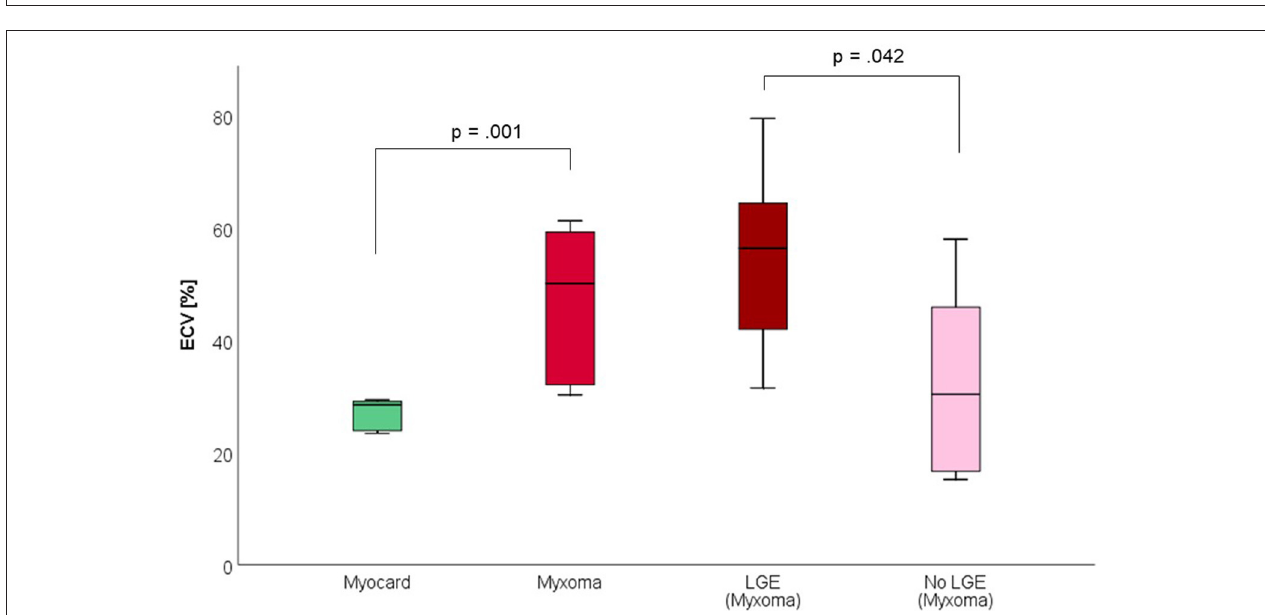
FIGURE 5 | Extracellular volume fraction (ECV, in %) of myocardium and myxoma. Where areas with and without LGE were discernible, respective measurements were taken.